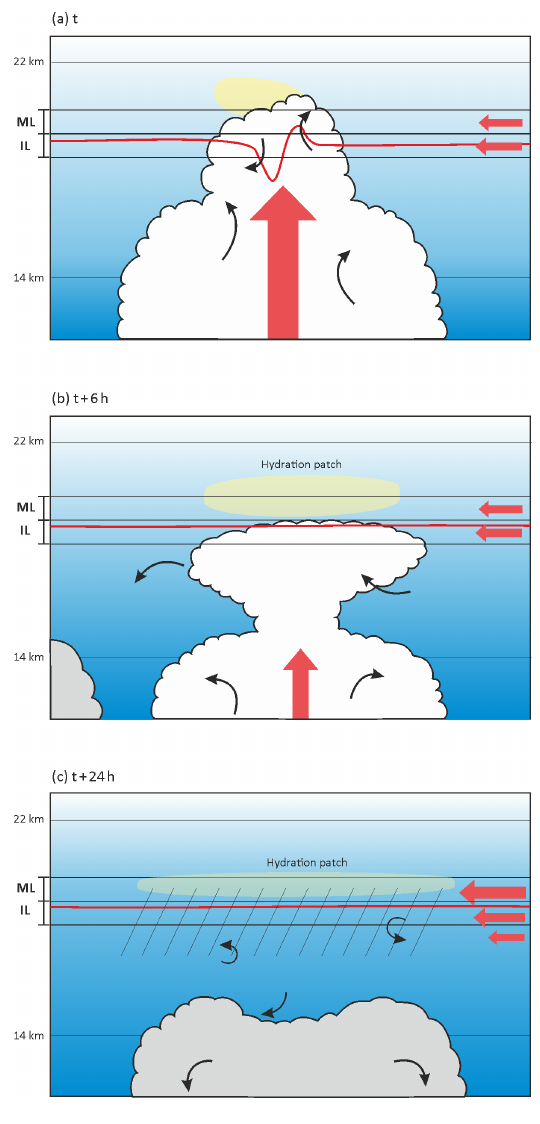
Figure 13. Schematic illustration summarizing the hydration pro- cess in the TTL during flight no. 7 of the StratoClim 2017 field campaign. (a) Mixing of the overshoots with the stratospheric air, (b) and (c) turbulent mixing of the hydration patch with the tropo- spheric air by vertical wind shear. The bottom and top of the TTL, at 14 and 22km, and the moist layer (ML) and ice layer (IL) are rep- resented by the black solid line, and the 410K isentropic altitude is represented by the red solid line. The main force in the TTL is marked by bold red arrows, while the turbulent eddies in and around the developed and weakened overshoots are described by black ar- rows. The overreaching water vapour above the cloud top level is indicated by a yellow ellipse in (a) . The hydration patch is shaded in yellow in (a) and (b) , and the layer of dehydration by turbulent diffusion and water vapour deposition followed by ice sedimenta- tion is hatched in (c) . The blue shading illustrates the concentration of tropospheric air, showing the increased tropospheric air in the TTL by the turbulent mixing in (b) and (c)